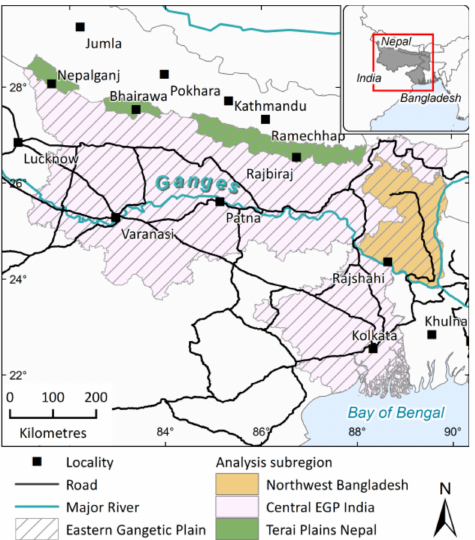
Figure 1. Location and area map of the Eastern Gangetic Plain (EGP)